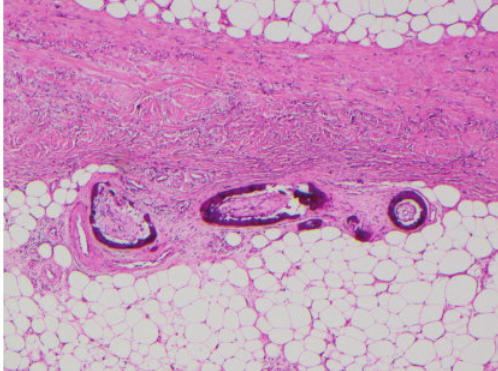
Figure 3: Characteristic biopsy specimen of CUA demonstrating circumferential calcification of small blood vessels with narrowing of the vascular